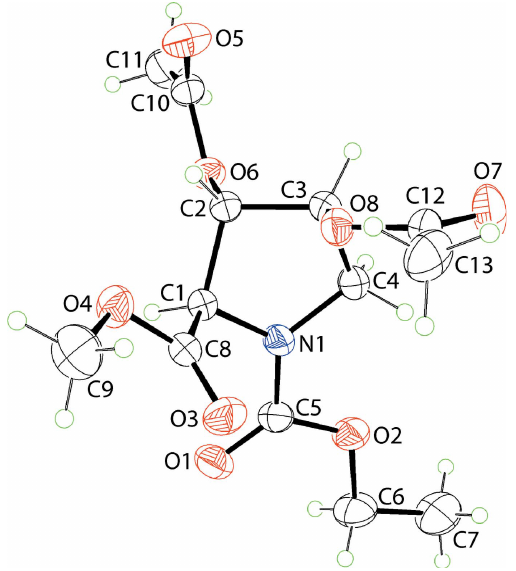
Figure 1 The molecular structure of (II), showing the atom-labelling scheme and displacement ellipsoids at the 35% probability level.